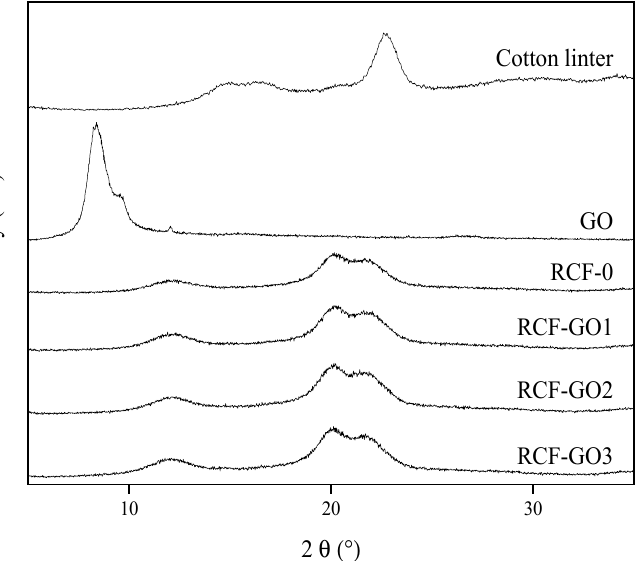
Figure 7. X-ray diffraction diffractograms of cotton linter pulp, RCF − 0, RCF − GO1, RCF − GO2, and RCF − GO3. Table 1. The crystallinity index of RCFs with and without GO.